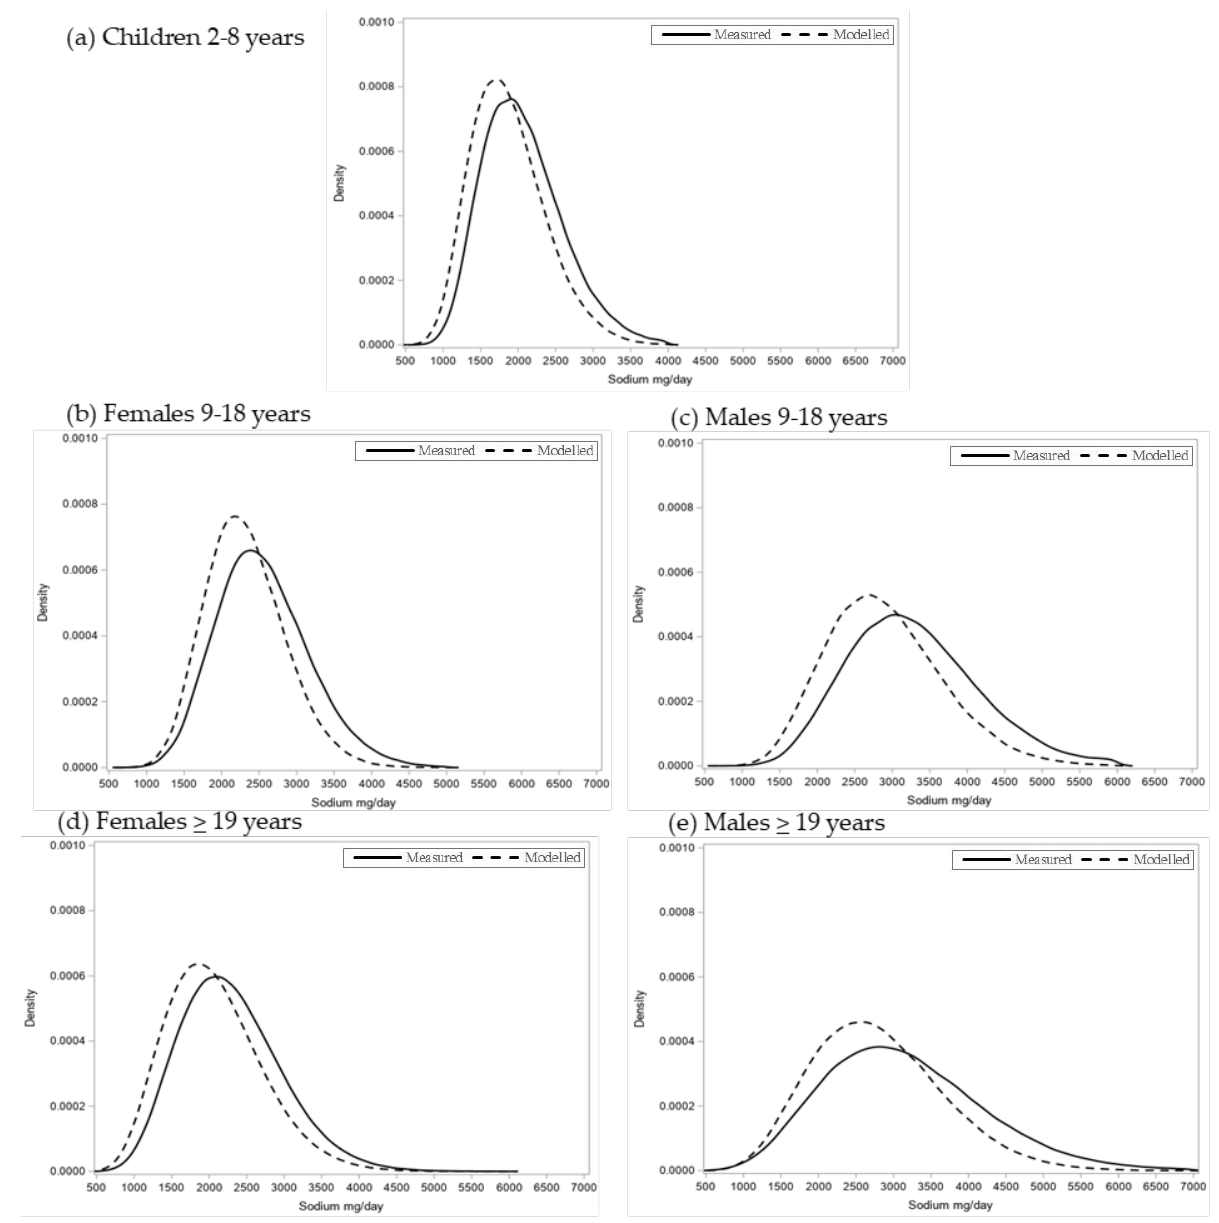
Figure 1. Estimated distribution of usual sodium intake (mg/day) reported at measured (solid line) and modelled full compliance to Health Canada’s voluntary Sodium Reduction Guidance (SRG) targets for processed food (dotted line) in ( a ) children 2 to 8 years, ( b ) females 9–18 years, ( c ) females ≥ 19 years, ( d ) males 9–18 years and ( e ) males ≥ 19 years from the 2015 Canadian Community Health Survey—Nutrition ( n = 19,645). Results are generated using the NCI method and applying 100 Monte Carlo simulations. Results are weighted and adjusted for age, sex (children 2–8 years), misreporting, sequence of recall and weekend/weekday recall. Distributions are trimmed according to Statistics Canada vetting